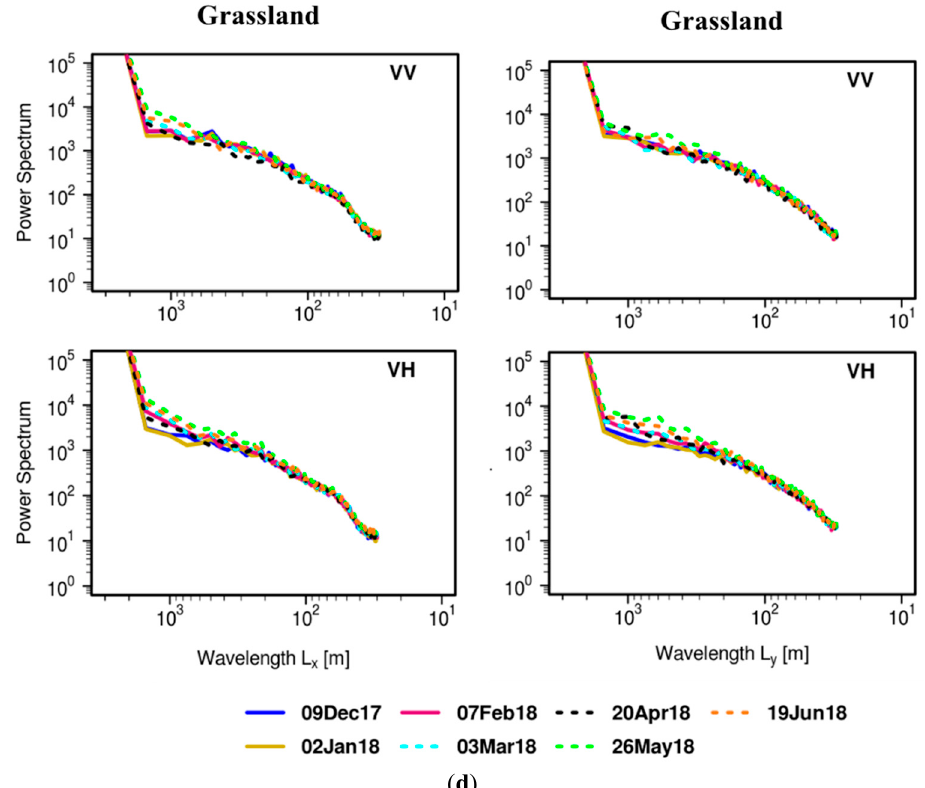
Figure 14. ( a ) BSC power spectra for grassland, mixed grassland and forest, and forest cover over Grand Mesa for VV (left) and VH (right) polarizations in the x-direction (W–E) during 2017. The black vertical lines in the top left panel mark the range of scales used to calculate the spectral slopes (Table S1a–c); the green vertical line marks the scaling break from steeper to flatter spectral slopes. ( b ) BSC power spectra for grassland, mixed grassland and forest, and forest cover over Grand Mesa for VV (left) and VH (right) polarizations in the y-direction (W–E) during 2017. ( c ) BSC power spectra of Grand Mesa for UAVSAR L-band (HV polarization) in the x-direction (W–E) (top) and the y-direction (N–S) (bottom) in the snow accumulation season of 2017. ( d ) BSC power spectra for grassland over Grand Mesa for VV (top) and VH (bottom) polarizations in the x-direction (W–E, left) and y-direction (N–S right) during 2018 (Table S2a,b).